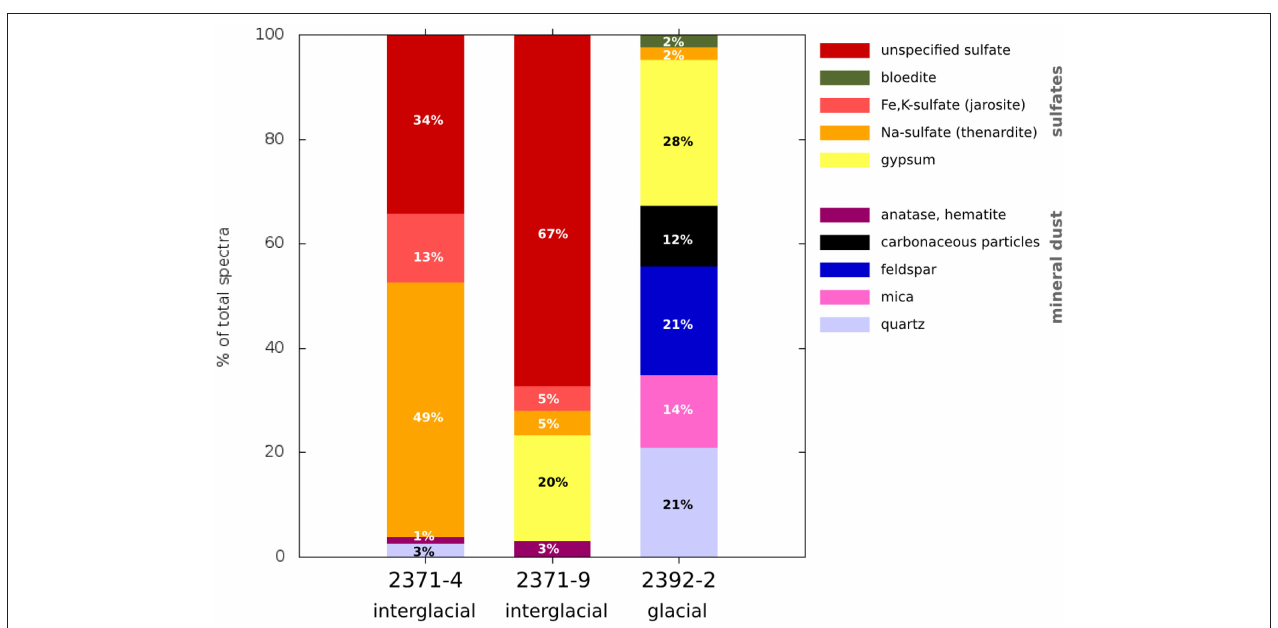
FIGURE 3 | Relative concentrations of identified species in percent within each sample. Different color families are used to distinguish between sulfate inclusions and mineral dust— cold colors for insoluble dust and rather warm colors for sulfates. While in the interglacial samples sulfate salts form 96% of the micro-inclusions, in the glacial ice mineral dust is most